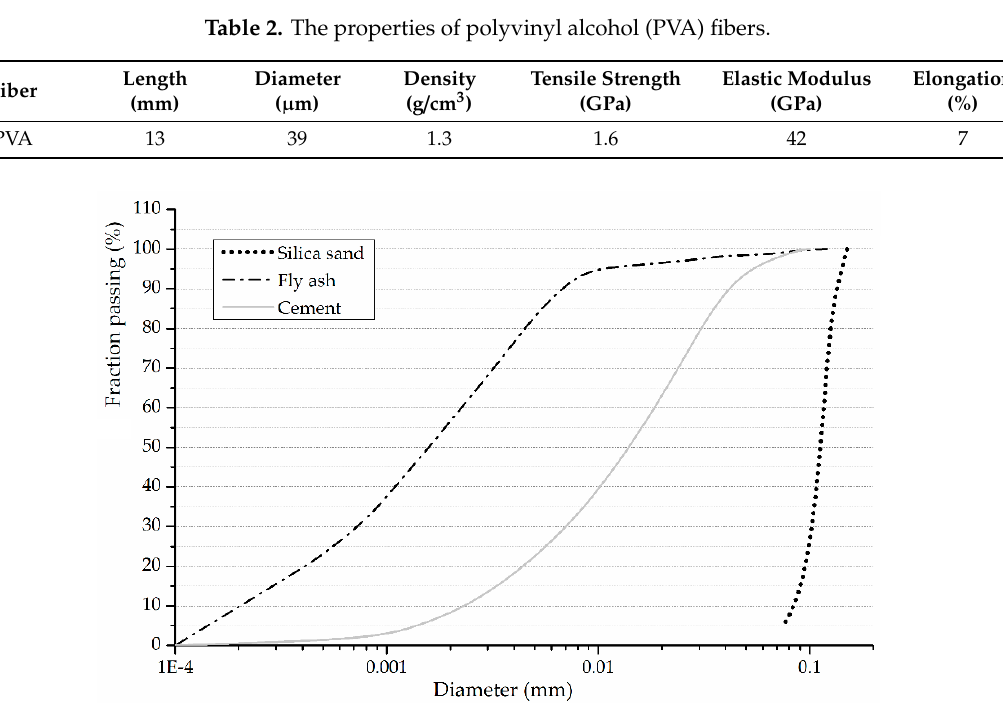
Table 1. The chemical compositions of binders.